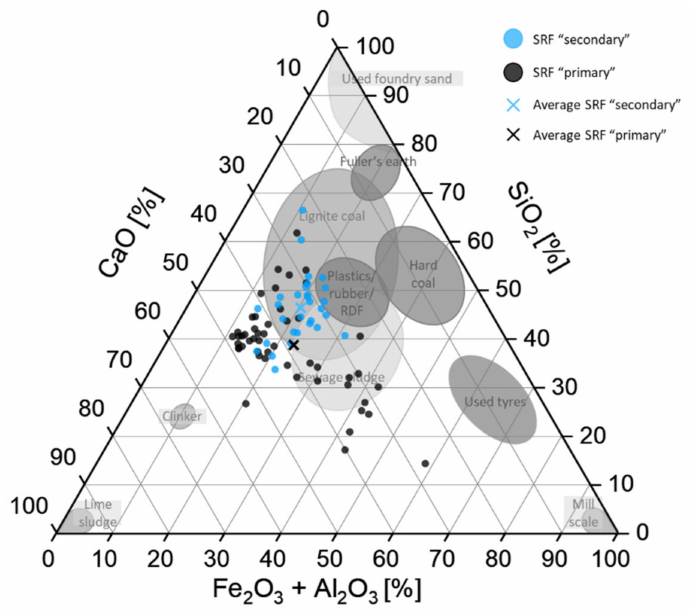
Figure 16. Ternary diagram illustrating the solid recovered fuel (SRF) ash composition of 80 investi- gated SRF samples and their average composition compared with other relevant raw materials and fuels